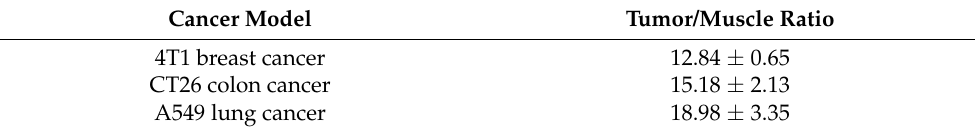
Figure 6. ( a ) SPECT/CT images and ( b ) biodistribution of 111 In-DOTA-NIR790 in mice bearing subcutaneous A549 lung cancer ( n = 3 at each time point). Arrow indicates tumor. Table 1. Tumor/Muscle Ratio of 111 In-DOTA-NIR790 in various cancer at 48 h after